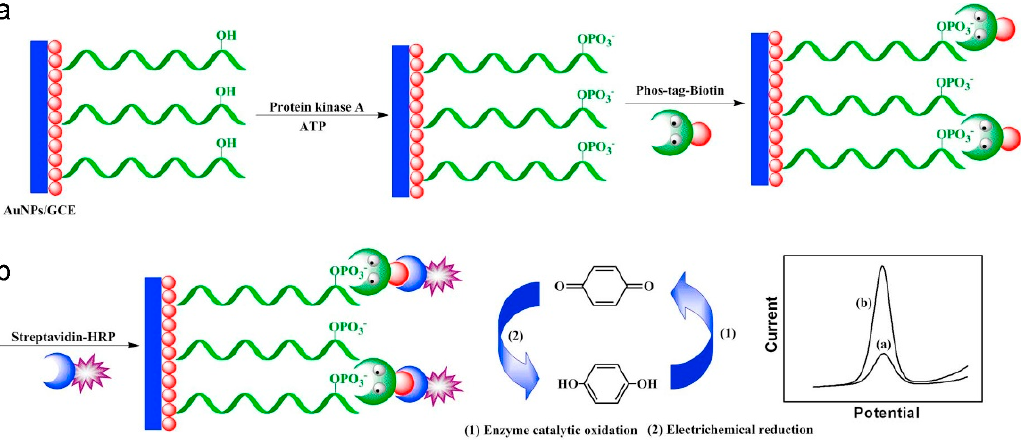
Figure 10. Detection of phenols as kinase inhibitors. ( a ): phosphorylation of the peptide matrix and binding of biotin; ( b ): binding of peroxidase and phenol oxidation. Reprinted from ref. [104] with permission of Elsevier.